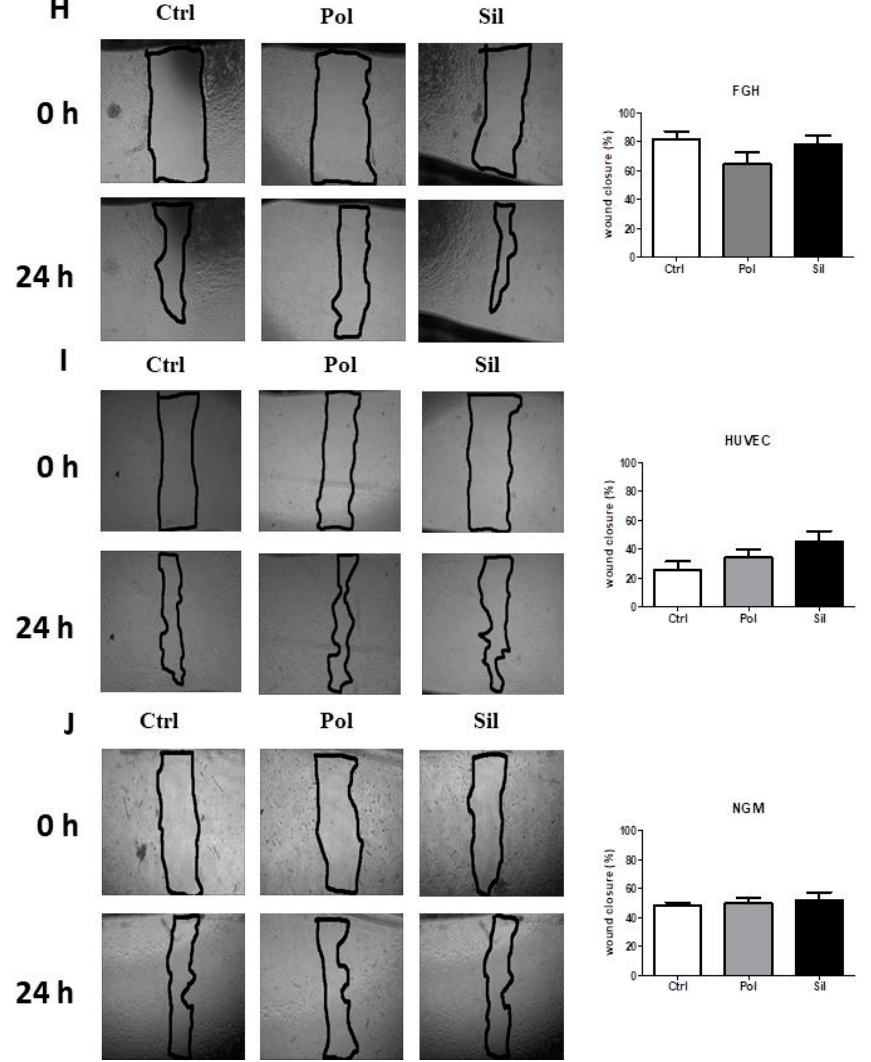
Figure 11. E ff ects of nanoparticles in tumor and non-tumor cells migration. Tumor cells (( A ). MV3 Figure 11. Effects of nanoparticles in tumor and non-tumor cells migration. Tumor cells ( A. MV3 B. ( B ). MDA-MB-231 ( C ). MCF-7 ( D ). U373 ( E ). PC-3 ( F ). AGS ( G ). HT-29) and non-tumor (( H ). FGH, ( I ). MDA-MB-231 C. MCF-7 D. U373 E. PC-3 F. AGS G. HT-29) and non-tumor ( H. FGH, I. HUVEC, J. HUVEC, ( J ). NGM) cells were cultured for 24 h in the absence (ctrl) or in the presence of 20 ug / mL of polymeric (Pol) or silica (Sil) nanoparticle. Mean e standard variation were calculated from 3 individual experiments (* p <